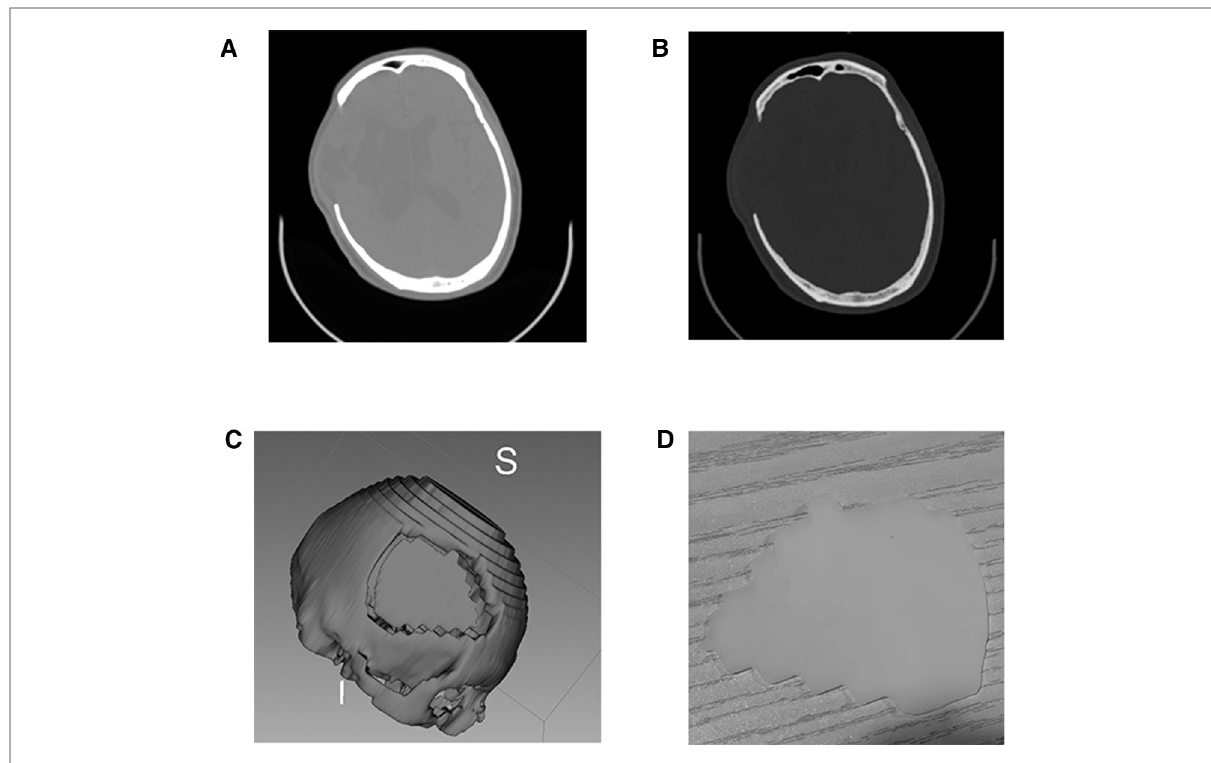
FIGURE 5 3D printed skull and mold from high resolution CT scan data. ( A,B ) High resolution CT scan data; ( C ) virtual mold in 3D Slicer; ( D ) 3D printed